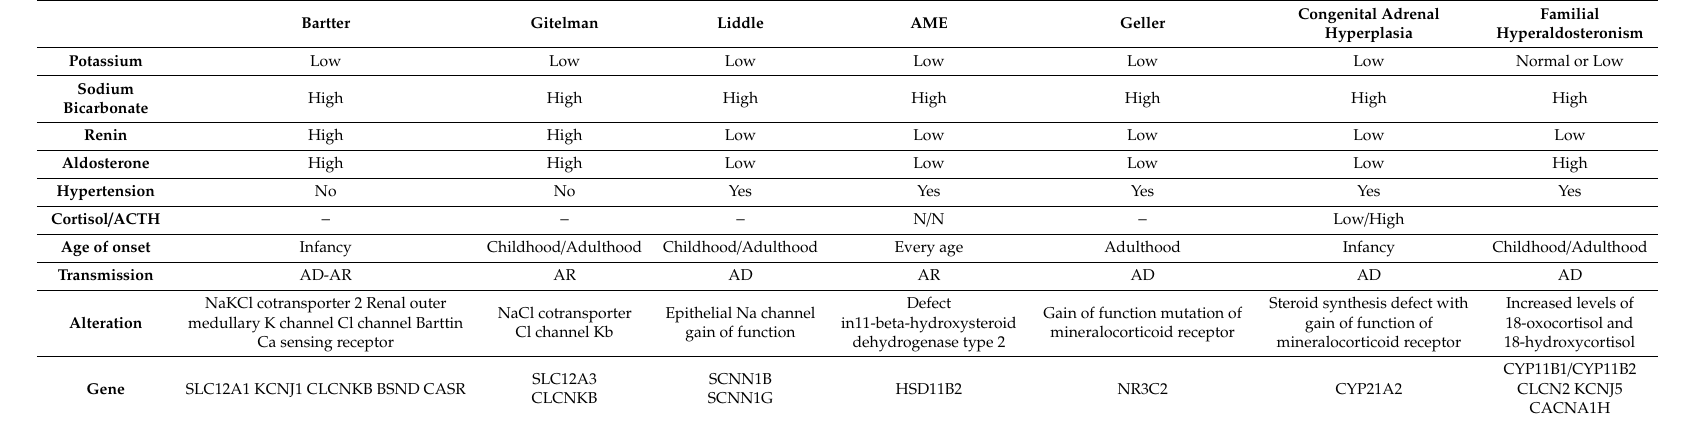
Table 2. Genetic and acquired diseases associated with hypokalemic metabolic alkalosis.